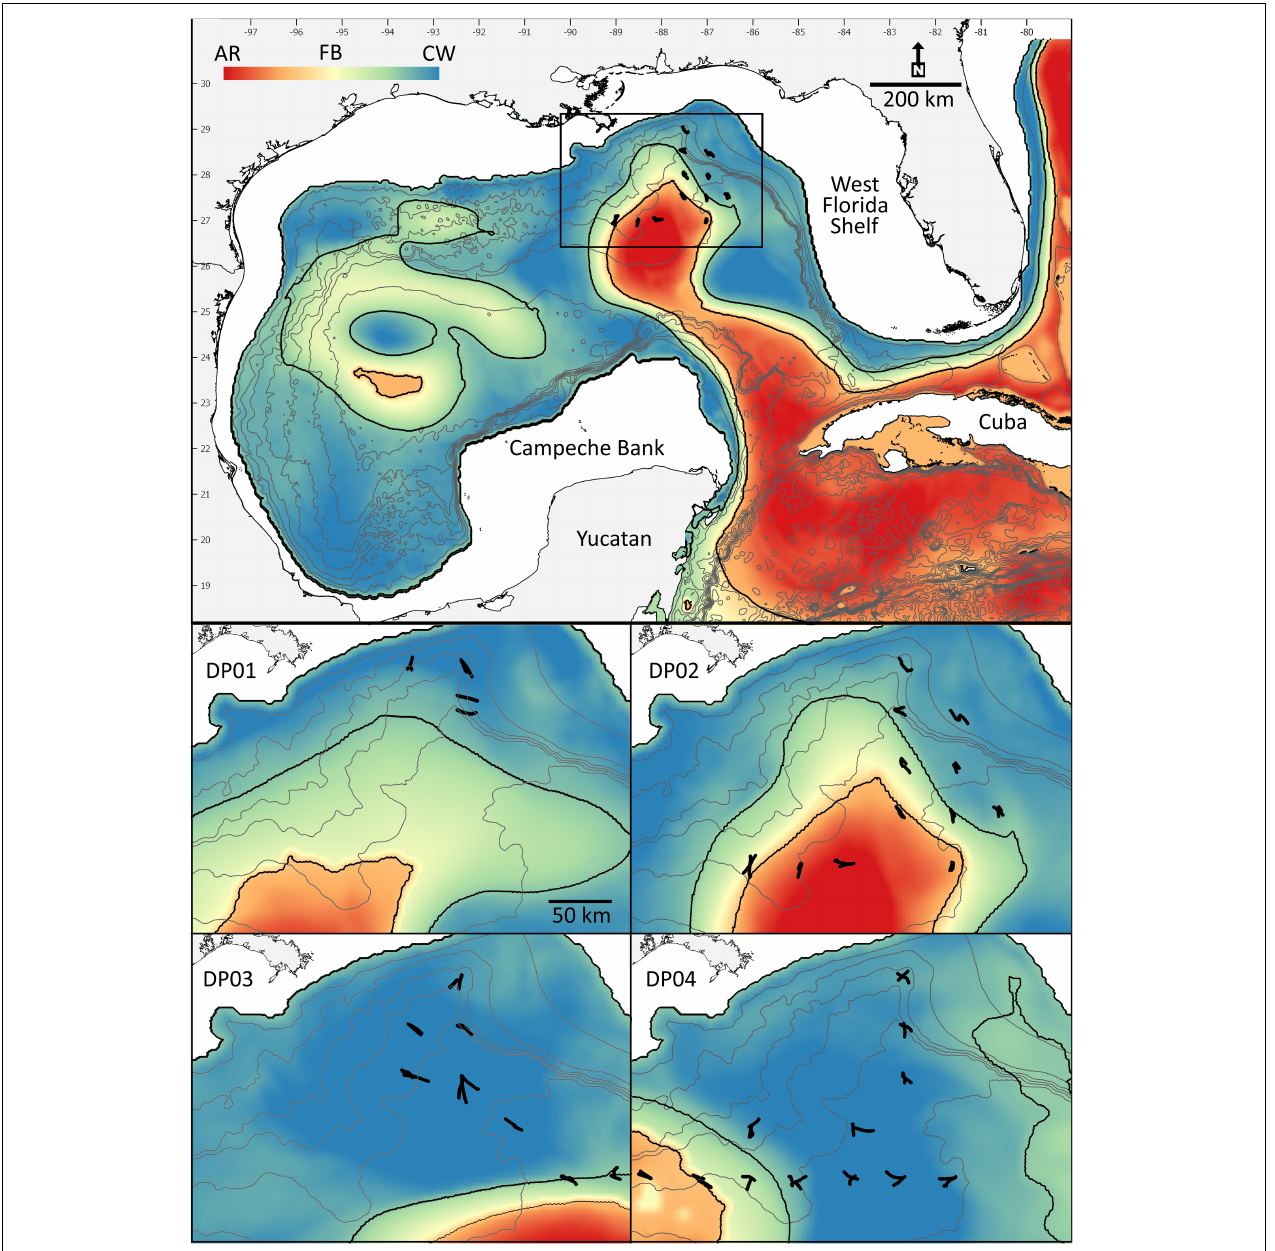
FIGURE 1 | Survey locations (filled symbols) overlaid on the feature classification map illustrating the gradients among the three primary features examined (Loop Current-origin water = red; frontal boundary = green; Gulf Common Water = blue). Lower panels represent survey tracks during each cruise (DP01–DP04). Contour lines represent 500 m depth